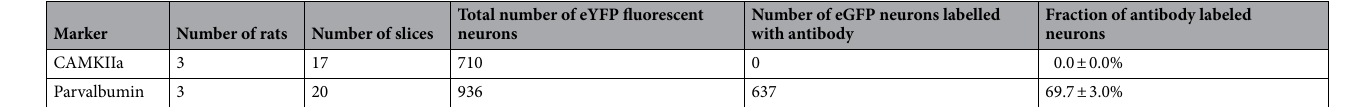
Total number of eYFP fluorescent Marker Number of rats Number of slices Table 6. Summary of rAAV5-PV-ChR2H134R-eYFP co-expression in area V1/V2.